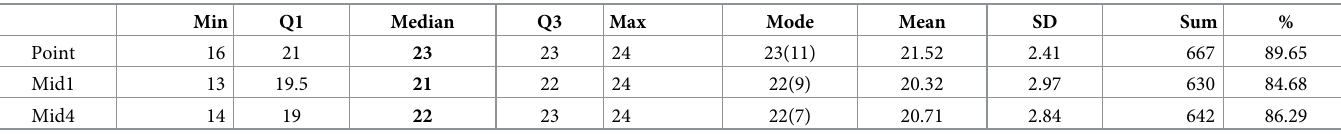
Number of participants per mode in parentheses (out of n = 31). Percentage of total SWI-cases was calculated as the sum of SWI-cases divided by 744 (the total number of